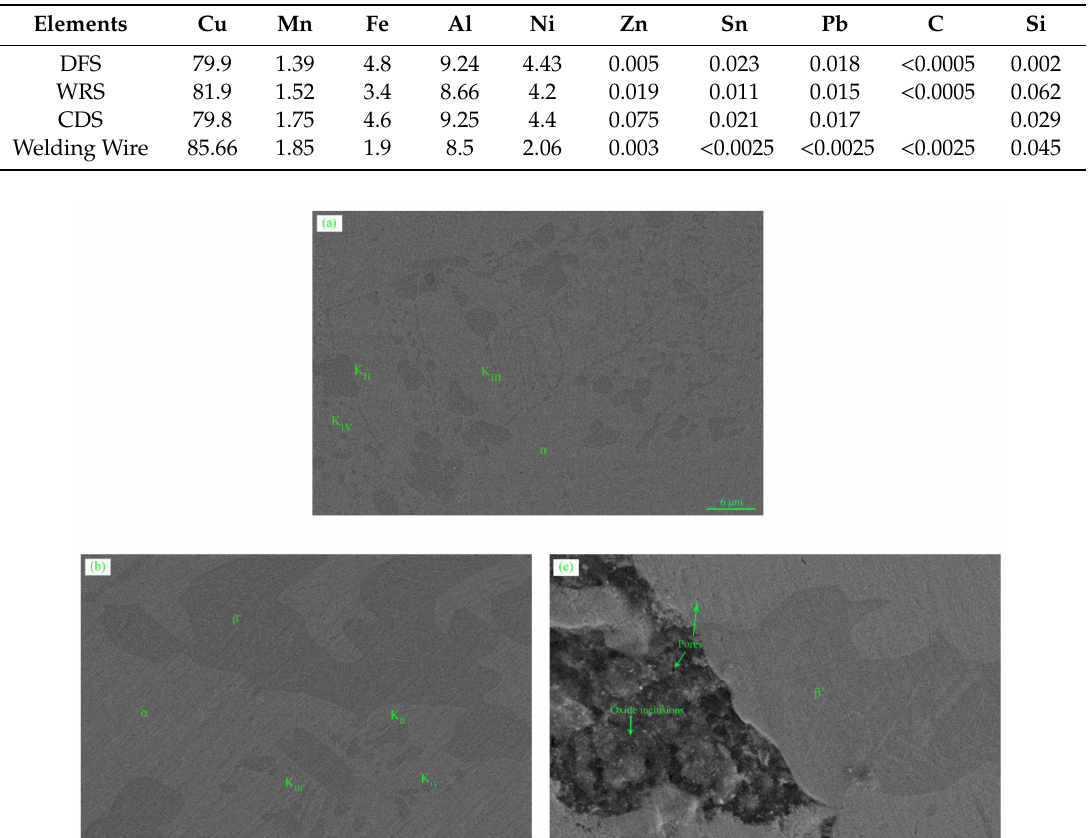
Table 1. Composition of DFS, WRS, CDS and welding wire (wt.%).